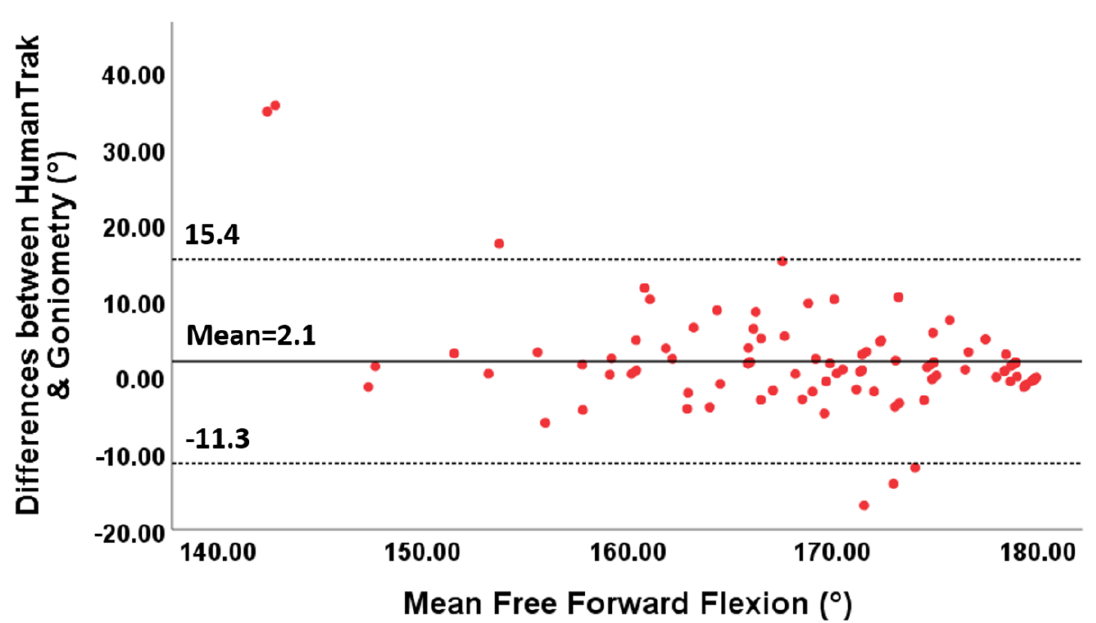
Figure 6. Bland–Altman plots for free forward flexion with limits of agreement. The differences between the two devices are plotted on the Y-axis, and the mean scores are plotted on the X-axis.